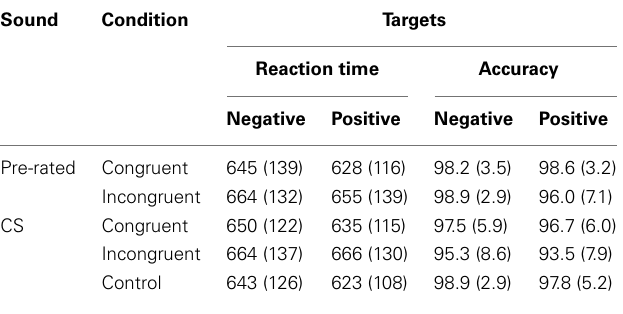
Table 2 | Mean (SD) of reaction times (ms) and accuracy (percentage correct) for theAPT on the congruent, incongruent, and control trials per level of target